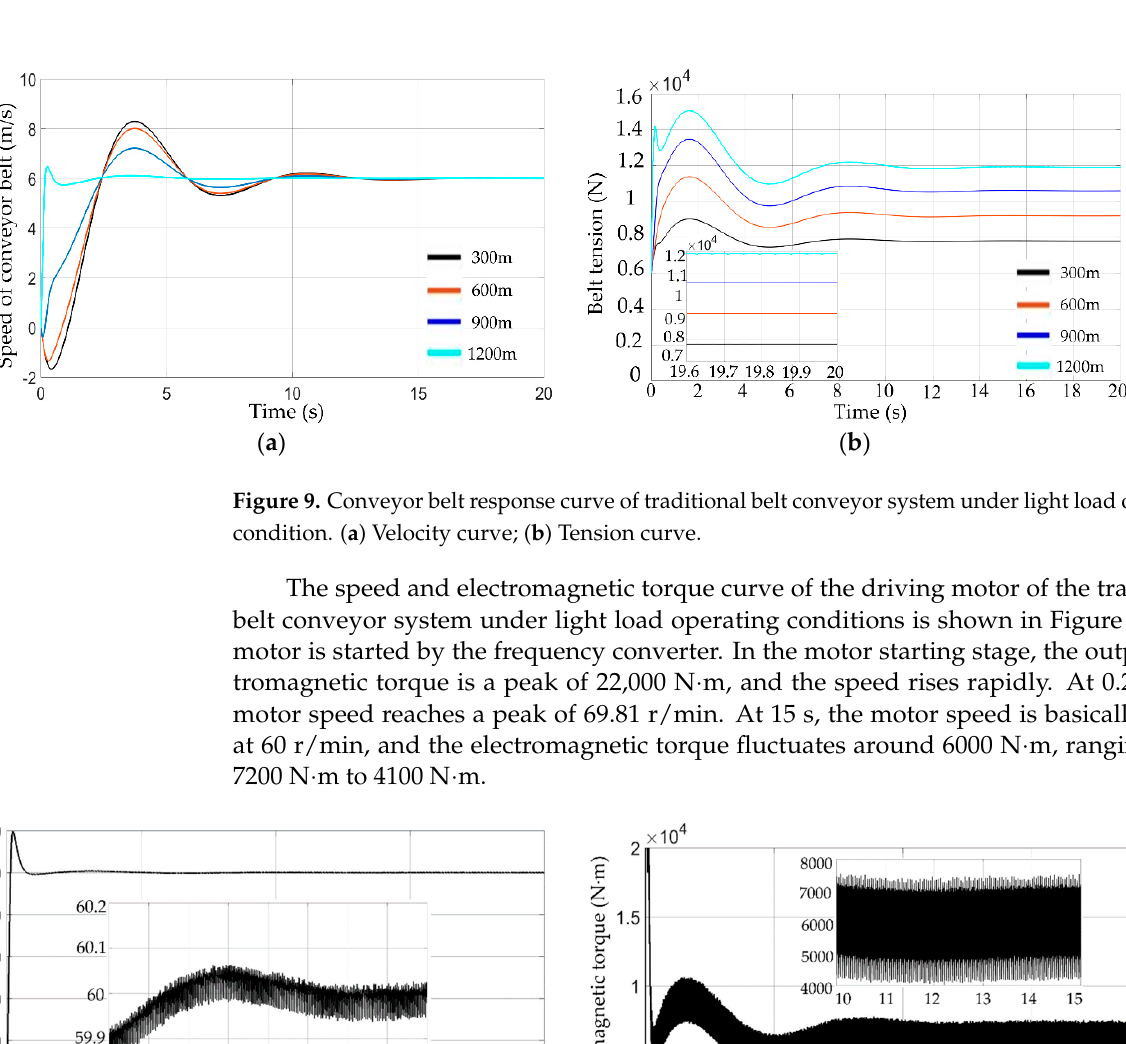
10 of 19 Figure 8. Distribution of observation points on the distributed permanent magnet direct-drive belt conveyor. In addition, the parameters of the drive motor of the traditional belt conveyor system and the roller motor of the distributed permanent magnet direct-drive conveyor system are shown in Table 1. Table 1. Motor parameters. Parameter